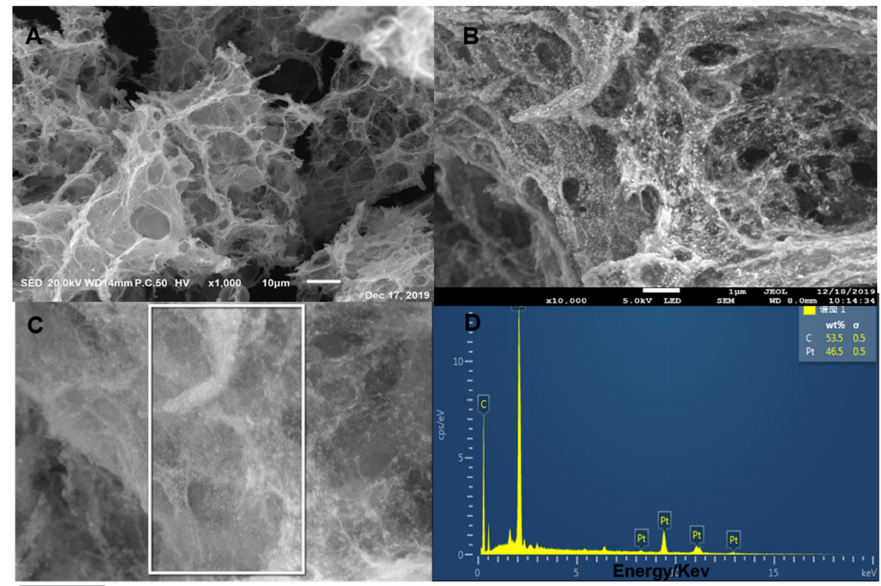
Figure 2. Scanning electron microscope (SEM) images at low ( A ) and high ( B ) magnifications of 3DPt / HGO composite, and an SEM image ( C ) with the corresponding energy-dispersive spectrometry (EDS) ( D ).